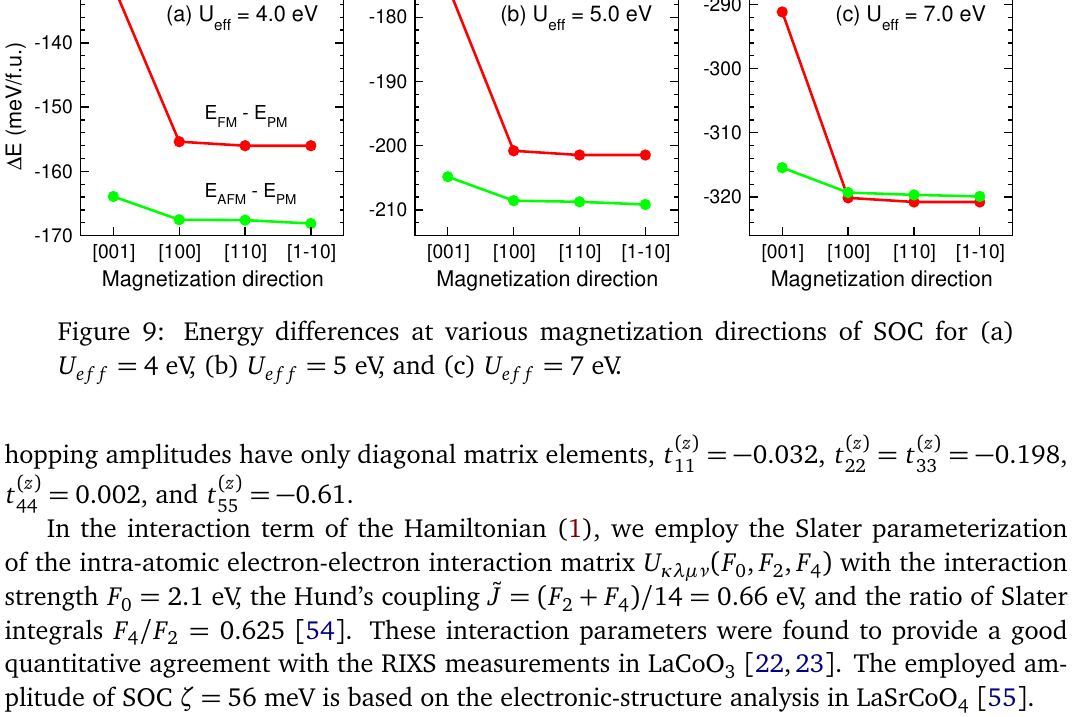
= − 0.198, = t ( z ) 33 22